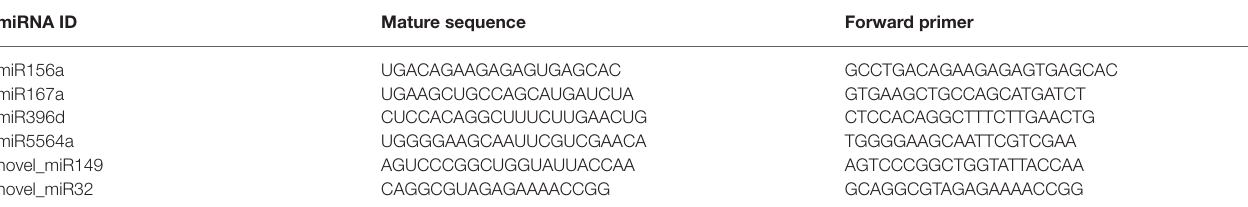
TABLE 1 | Primers information of qRT-PCR verification for selected six Miscanthus sinensis miRNAs. miRNA ID Mature sequence Forward primer